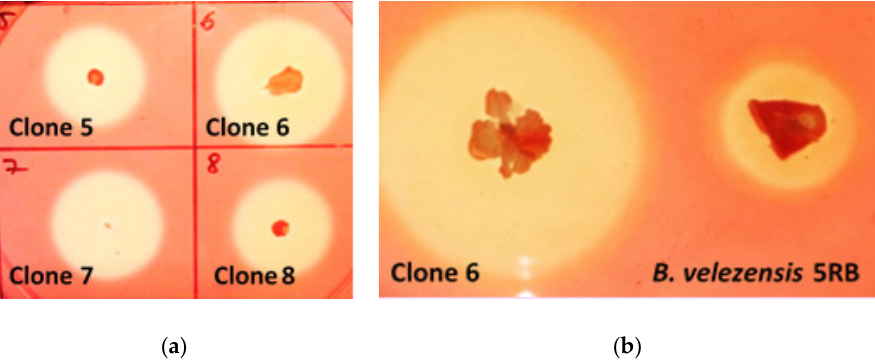
Figure 6. Zones of cellulose hydrolysis formed by recombinant B. velezensis clones containing the pBES_cel48S construct ( a ) and the selected clone 6 in comparison with the host strain ( b ). The cellulase activity of the selected B. velezensis clone 6 grown in the presence of 10 g/L CMC peaked at 72 h reaching 6.08 U, more than five times higher than that of the control BV/pBE-S ( B. velezensis 5RB containing the expression vector pBE-S). Interestingly, the exchange of CMC with α -cellulose as a carbon source led to the even higher activity of clone 6 compared to the control (5.27 vs 0.75 U at 72 h), which represents a seven-fold increase in total cellulase activity (Figure 7).